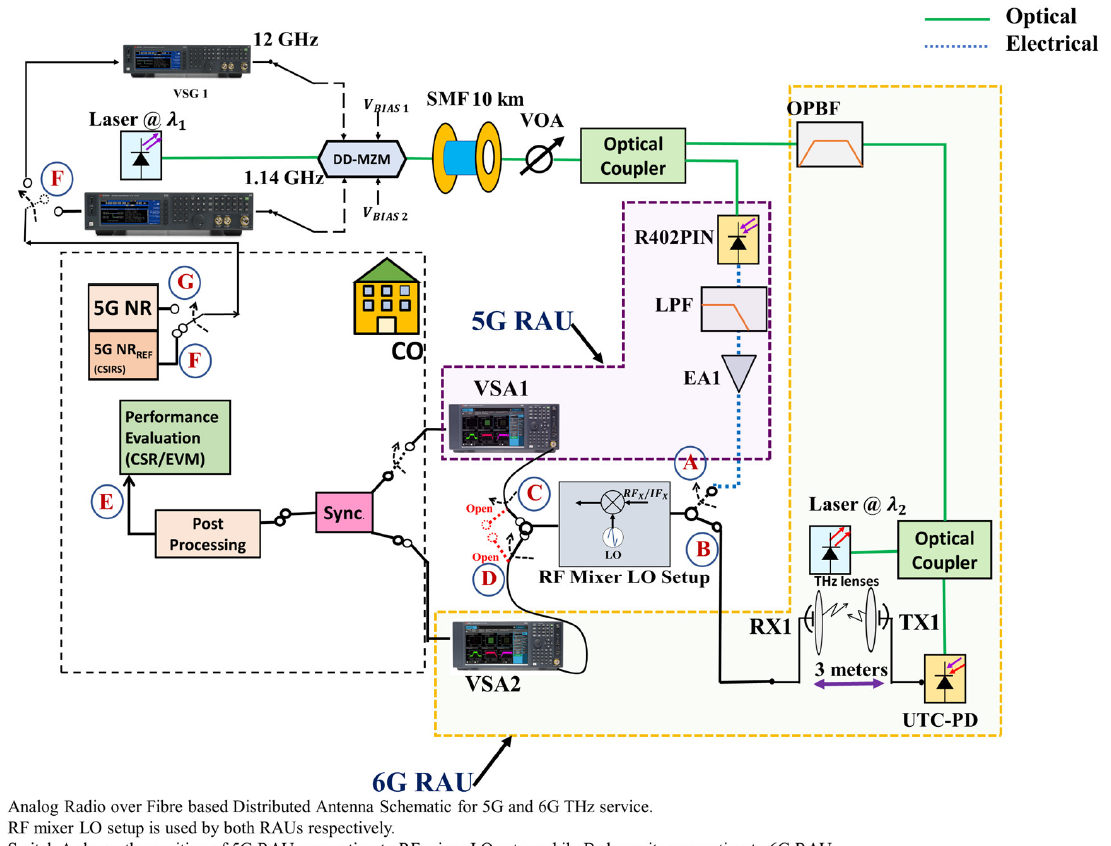
Figure 3. RoF OFH integration system with DAS for IF carriers. A Mach-Zehnder as an external modulator is used with a single mode fibre of 10 km deployed.